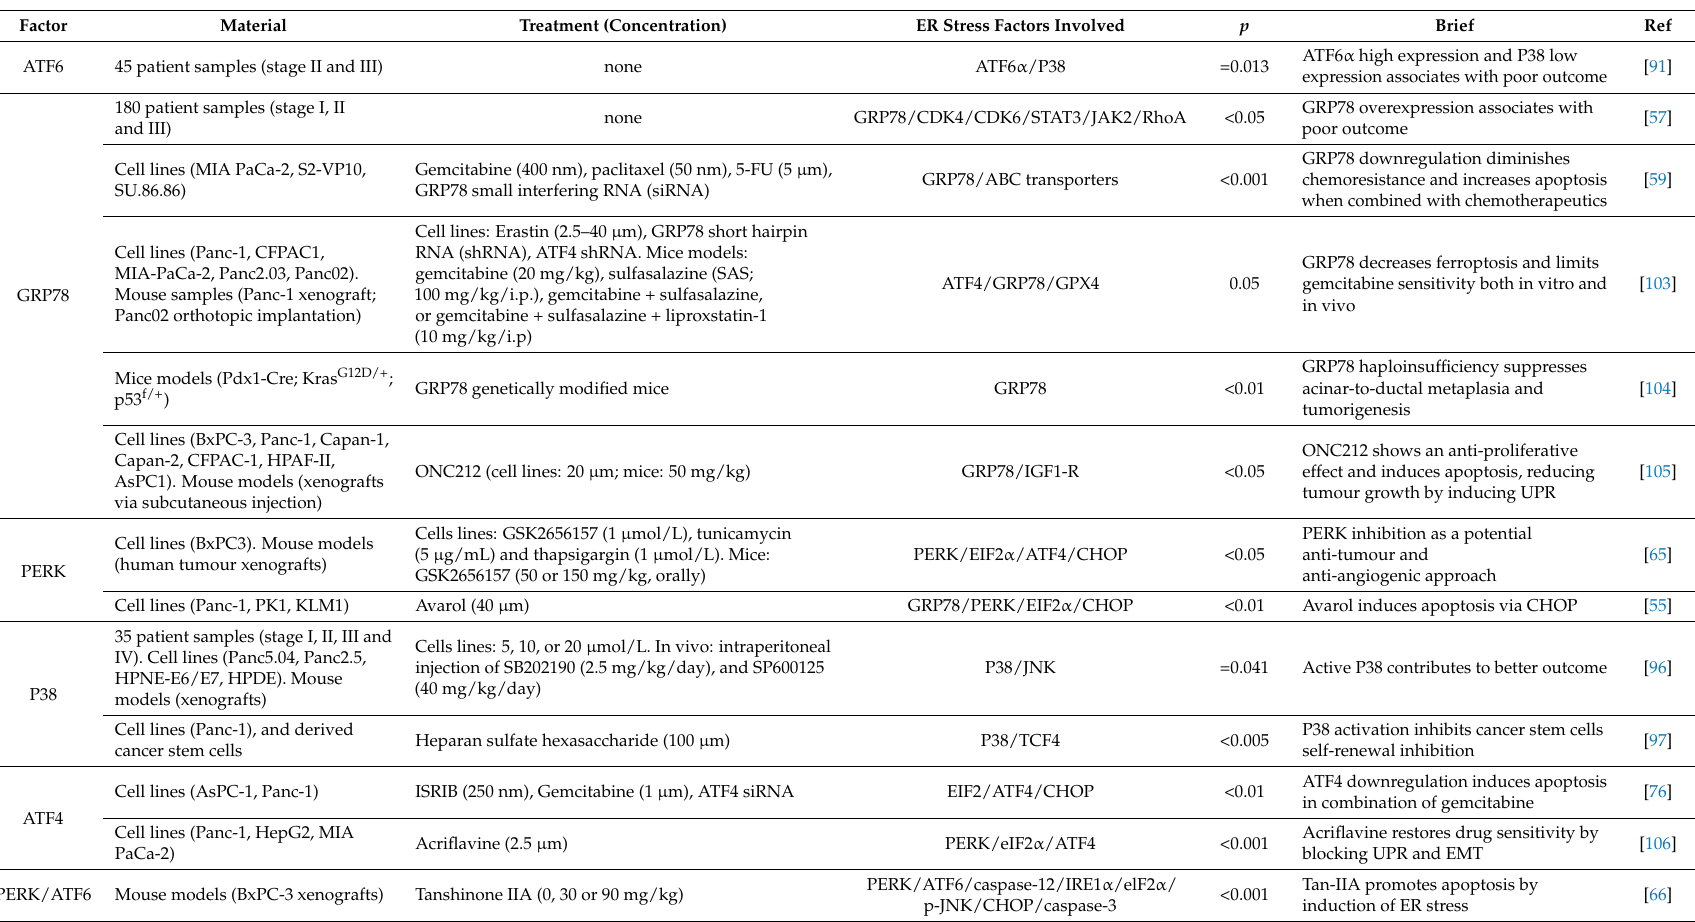
Table 1. Pre-clinical studies with ER stress response factors against pancreatic ductal